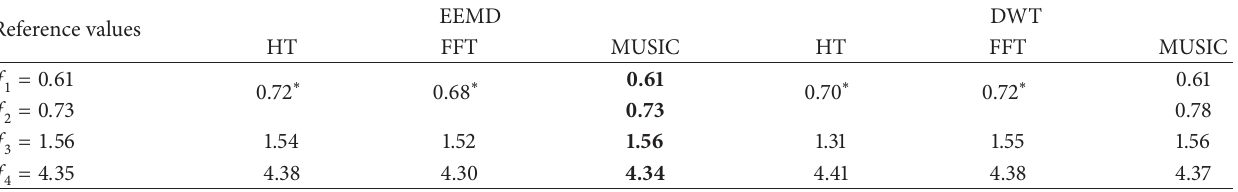
Table 1: Results of identified natural frequencies with different